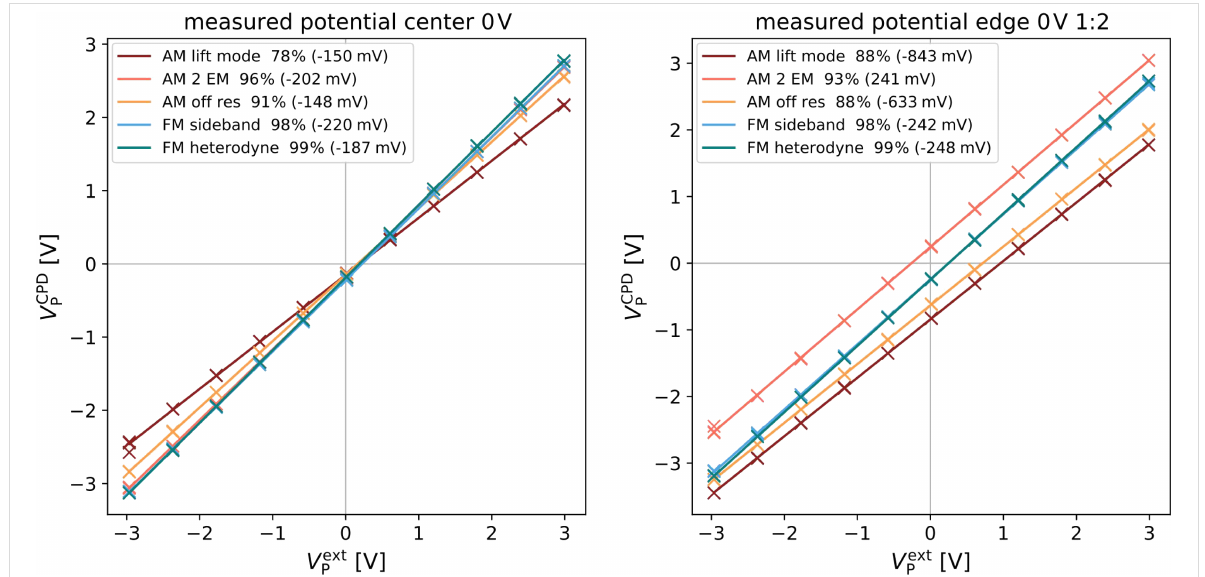
Figure 7: Comparison of the absolute measured potential plotted against the applied potential for AM (warm colors) and FM (cool colors). Legend in the upper left shows the measured CPD at 0 V applied voltage in brackets. Data shown captured in the middle of the electrode structure (left) and on the outer most electrodes (1/2) (right) without an additional electrostatic force.